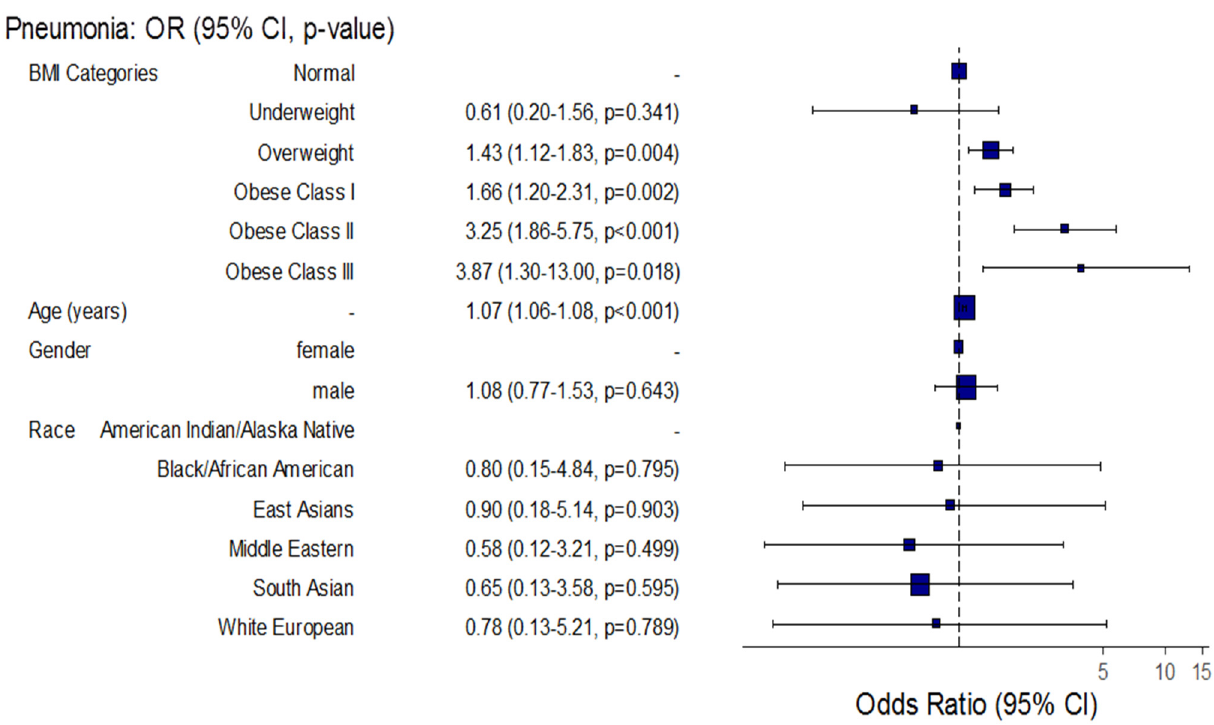
Figure 4. Forest plot for the association between BMI and the incidence of pneumonia among hospitalized COVID-19 patients. Table 5. Relationship between patient BMI and the radiological findings of COVID ‐ 19.